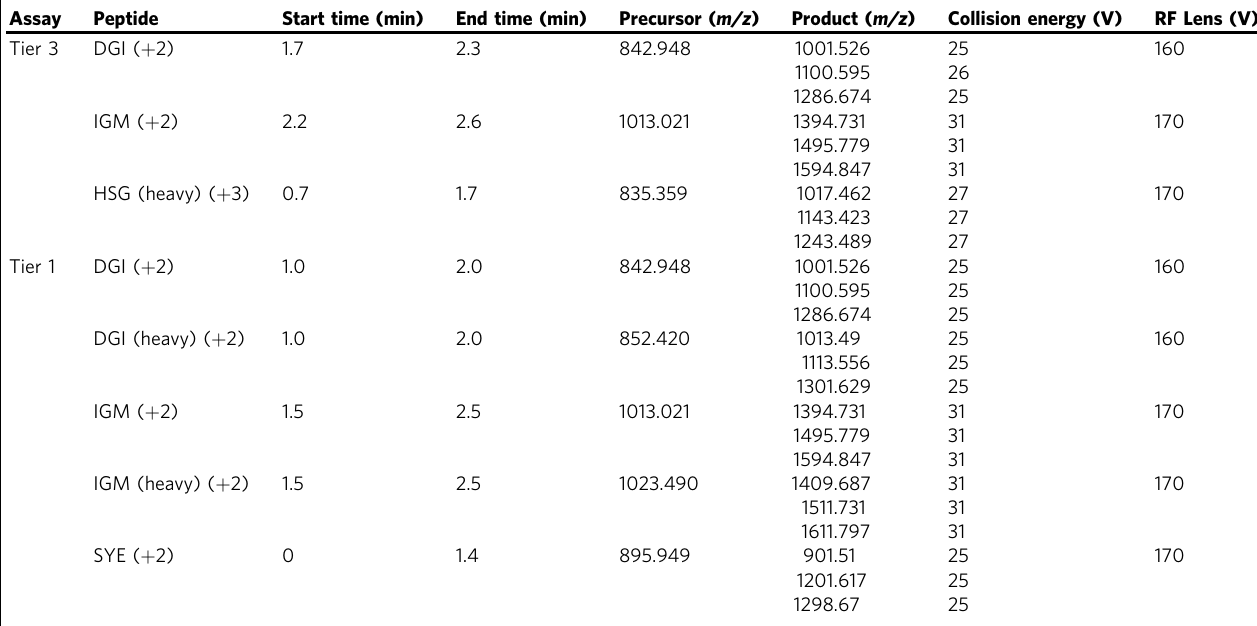
Table 4 Selected reaction monitoring (SRM) parameters for determination of SARS-CoV-2 targeted peptides. DGI: DGIIWVATEGALNTPK; IGM: IGMEVTPSGTWLTYTGAIK; HSG: HSGFEDELSEVLENQSSQAELK; and SYE: